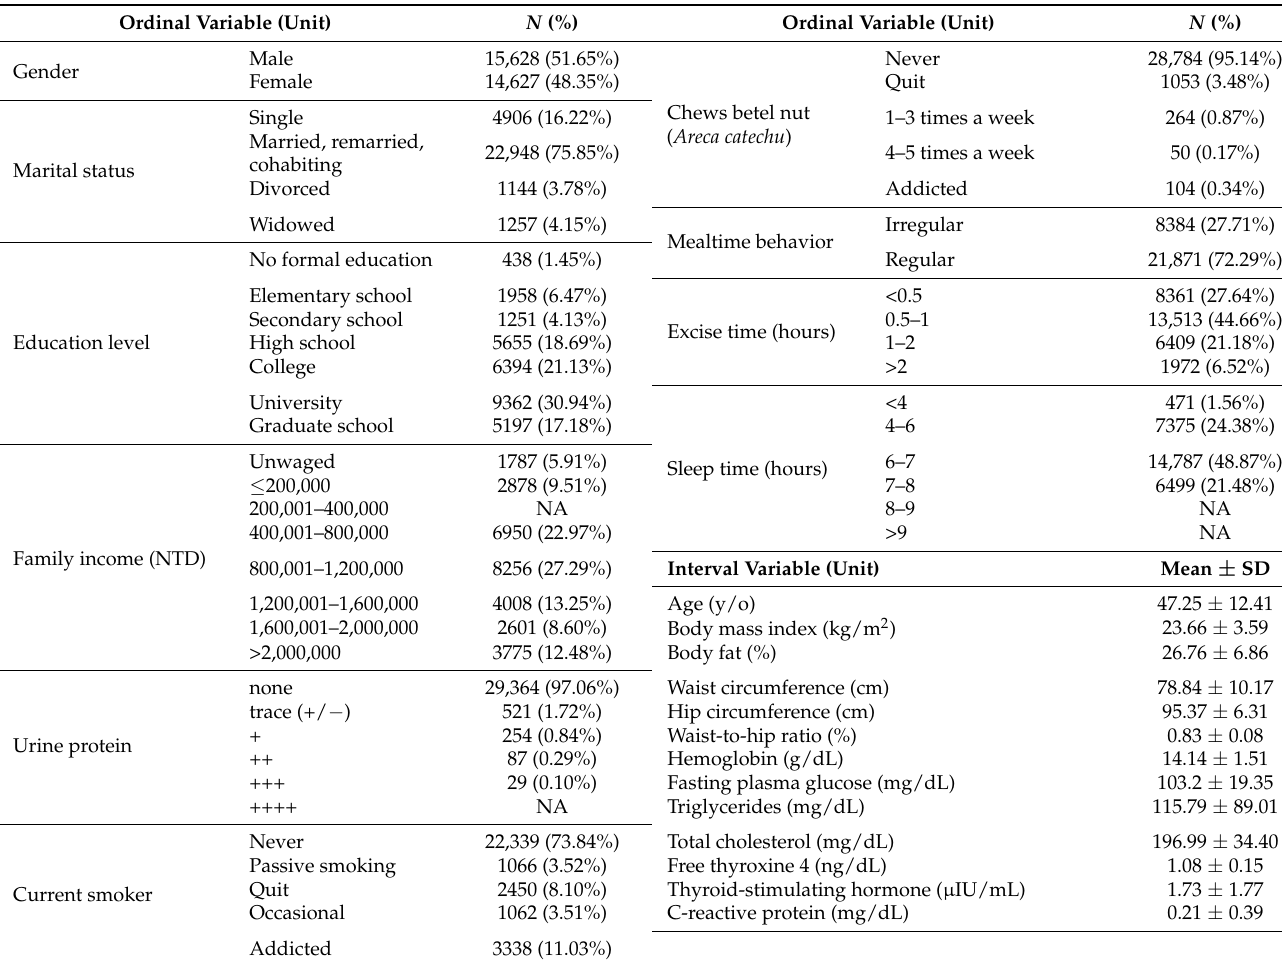
Table 2. The demographics statistical analysis of subjects’